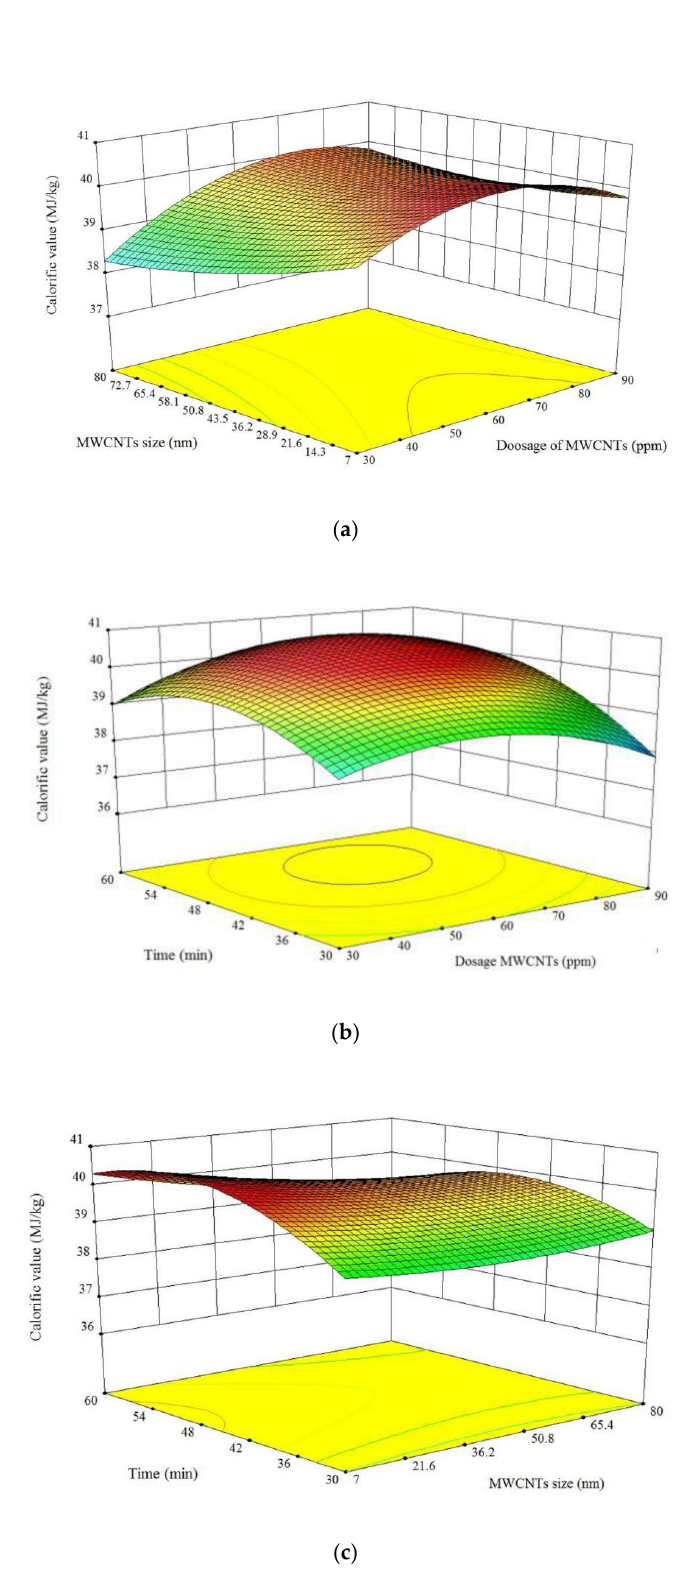
Figure 5. The three-dimensional surface plot which shows the combined e ff ects of: ( a ) time and multi-walled carbon nanotubes (MWCNTs) size; ( b ) time and dosage MWCNTs; ( c ) time and MWCNTs